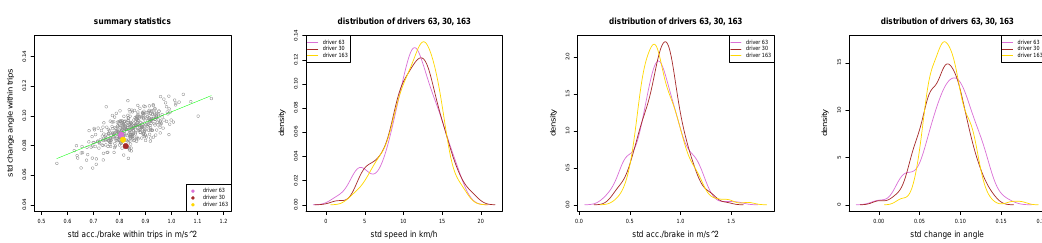
Figure 11. ( left ) Scatter plot ( σ a , σ ∆ ) of all n = 416 drivers with drivers 63, 30 and 163 in orchid, brown and yellow colors; ( middle and right ) density plots of σ v , s , σ a , s and σ ∆ , s for s = 1, . . . , S of the three drivers 63, 30 and 163.